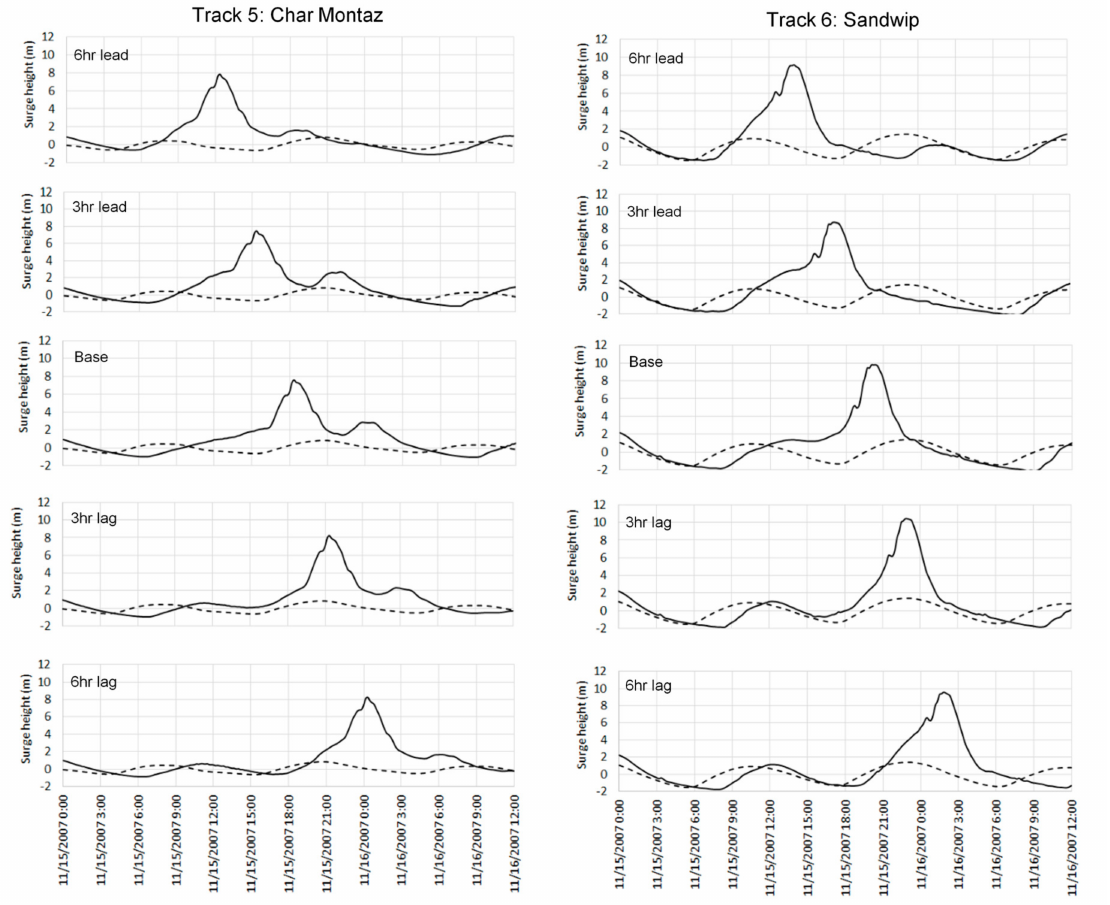
Figure 11. Surge profile (firm lines) along with local tidal water level (dotted line) at different tidal phases at landfall location for Track 5—Char Montaz ( left panel ), and at the landfall location for Track 6—Sandwip ( right panel